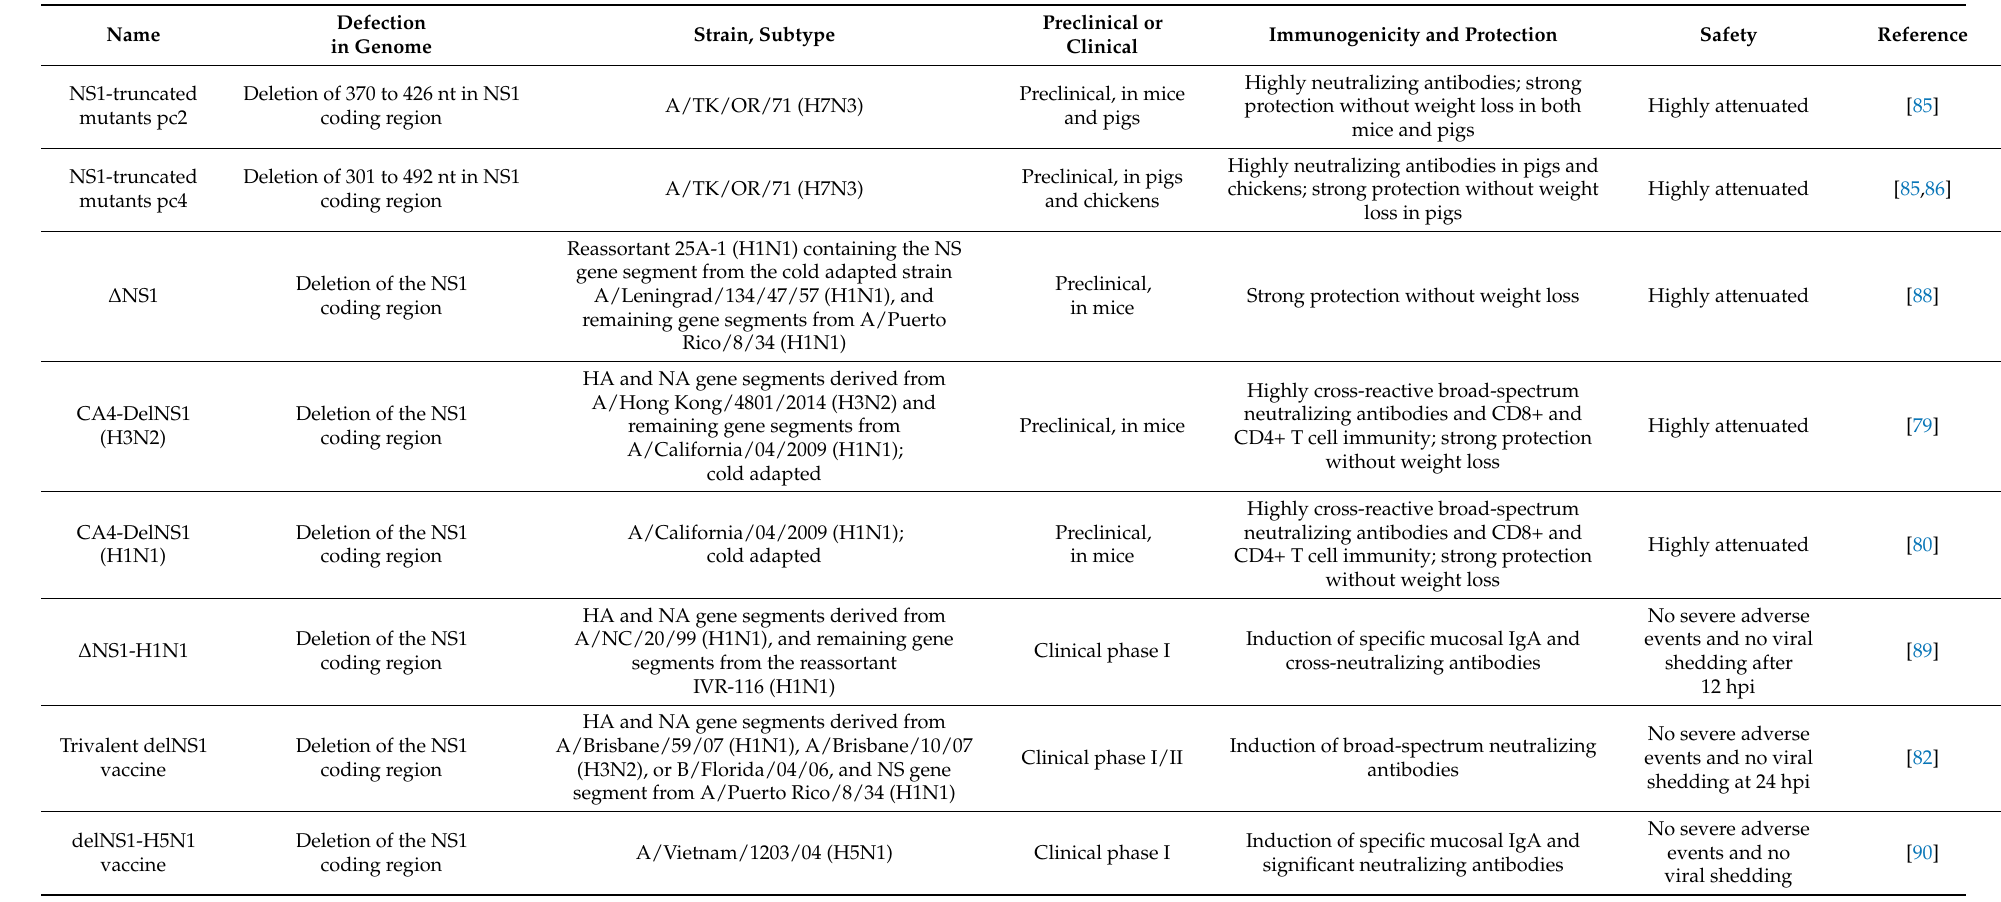
Table 2. Preclinical and clinical LAIVs based on NS1 gene deletion or defection